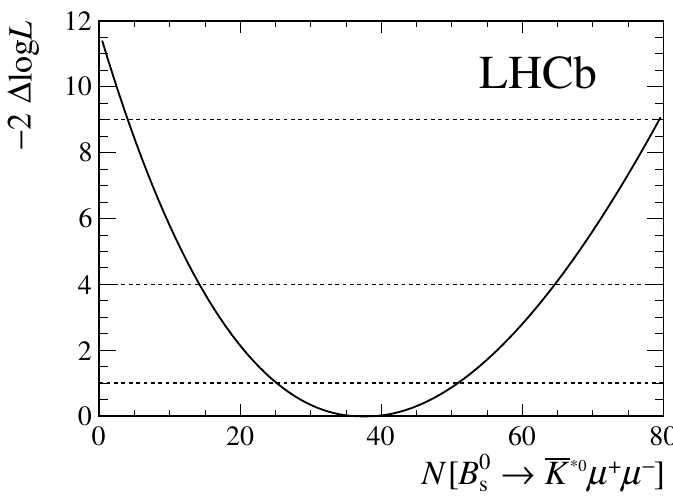
Figure 3 . Change in log-likelihood from the simultaneous (cid:12)t to the candidates in the two data- taking periods and the di(cid:11)erent bins of neural network response, as a function of the B 0 yield. Systematic uncertainties on the yield have been included in the